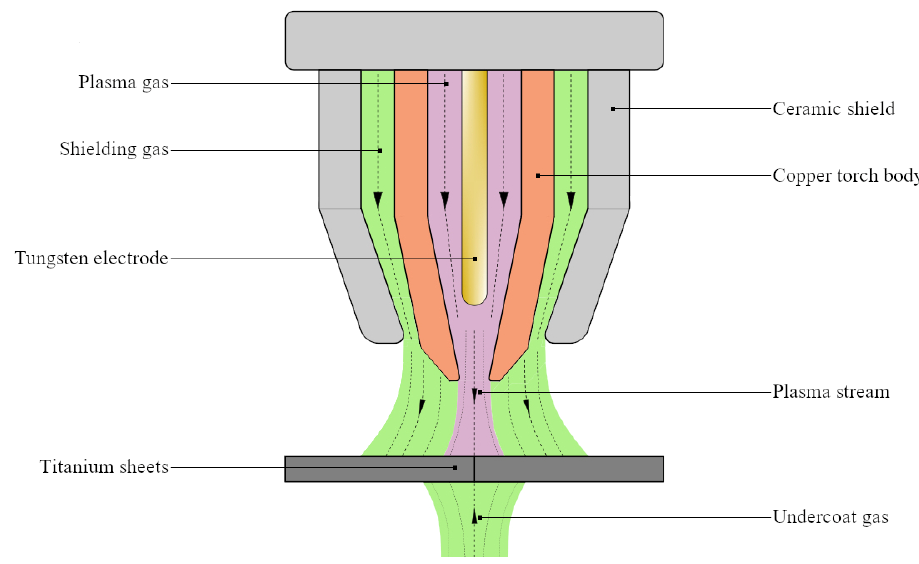
Figure 2. Simplified schematic of microplasma arc welding.